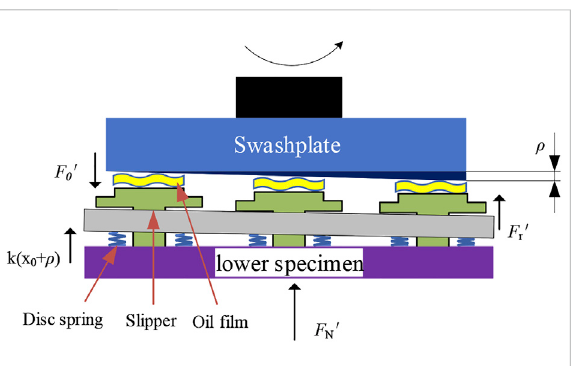
FIGURE 6 Schematic diagram of the residual pressing force